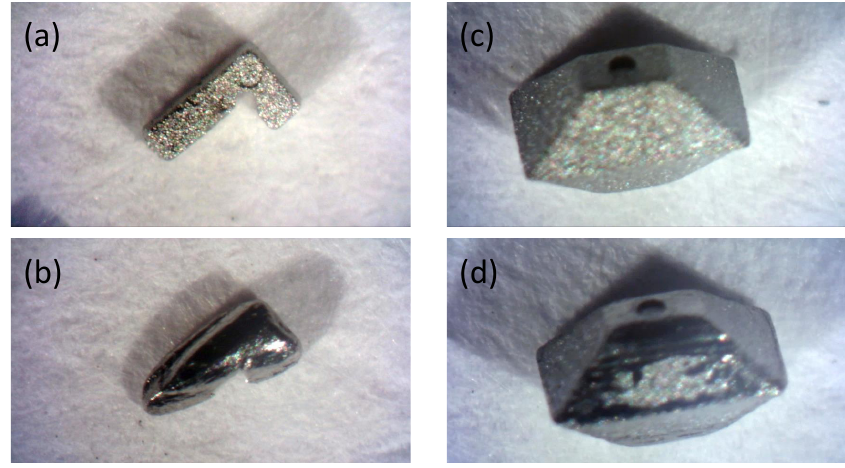
Figure 14. Geometrically derived particles: ( a ) L-angle before experiment. ( b ) L-angle after experi- ment. ( c ) Octahedron before experiment. ( d ) Octahedron after experiment.